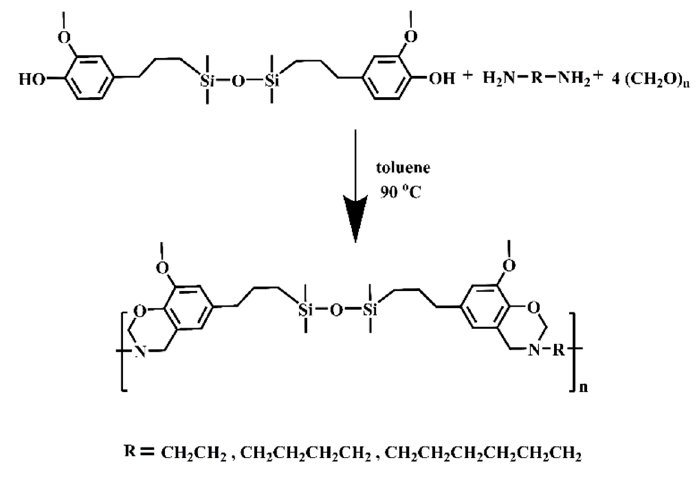
Figure 2. Illustration for the synthesis of poly (SIE-e), poly (SIE-b), and poly (SIE-d). Table 1. Feed composition, Gel Permeation Chromatograph (GPC) data, and viscosities of the synthesized benzoxazines.